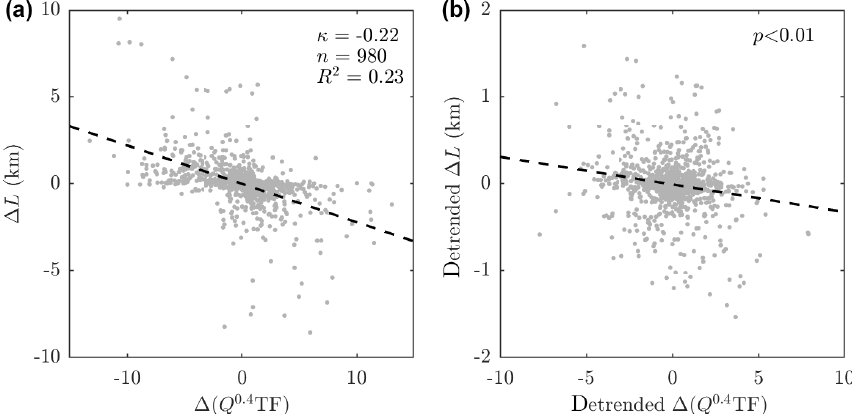
Figure 7. (a) Correlation of submarine melt anomaly versus terminus position anomaly for all glaciers. Each light grey point is a 5-year binned value for an individual glacier. The dashed black line is linear regression on the scatter, and statistics are given in the top right. Panel (b) is the same as panel (a) , but a linear trend in time for each glacier has been removed from both the submarine melt and terminus position, outliers have been removed, and the p value also accounts for autocorrelation (Sect.